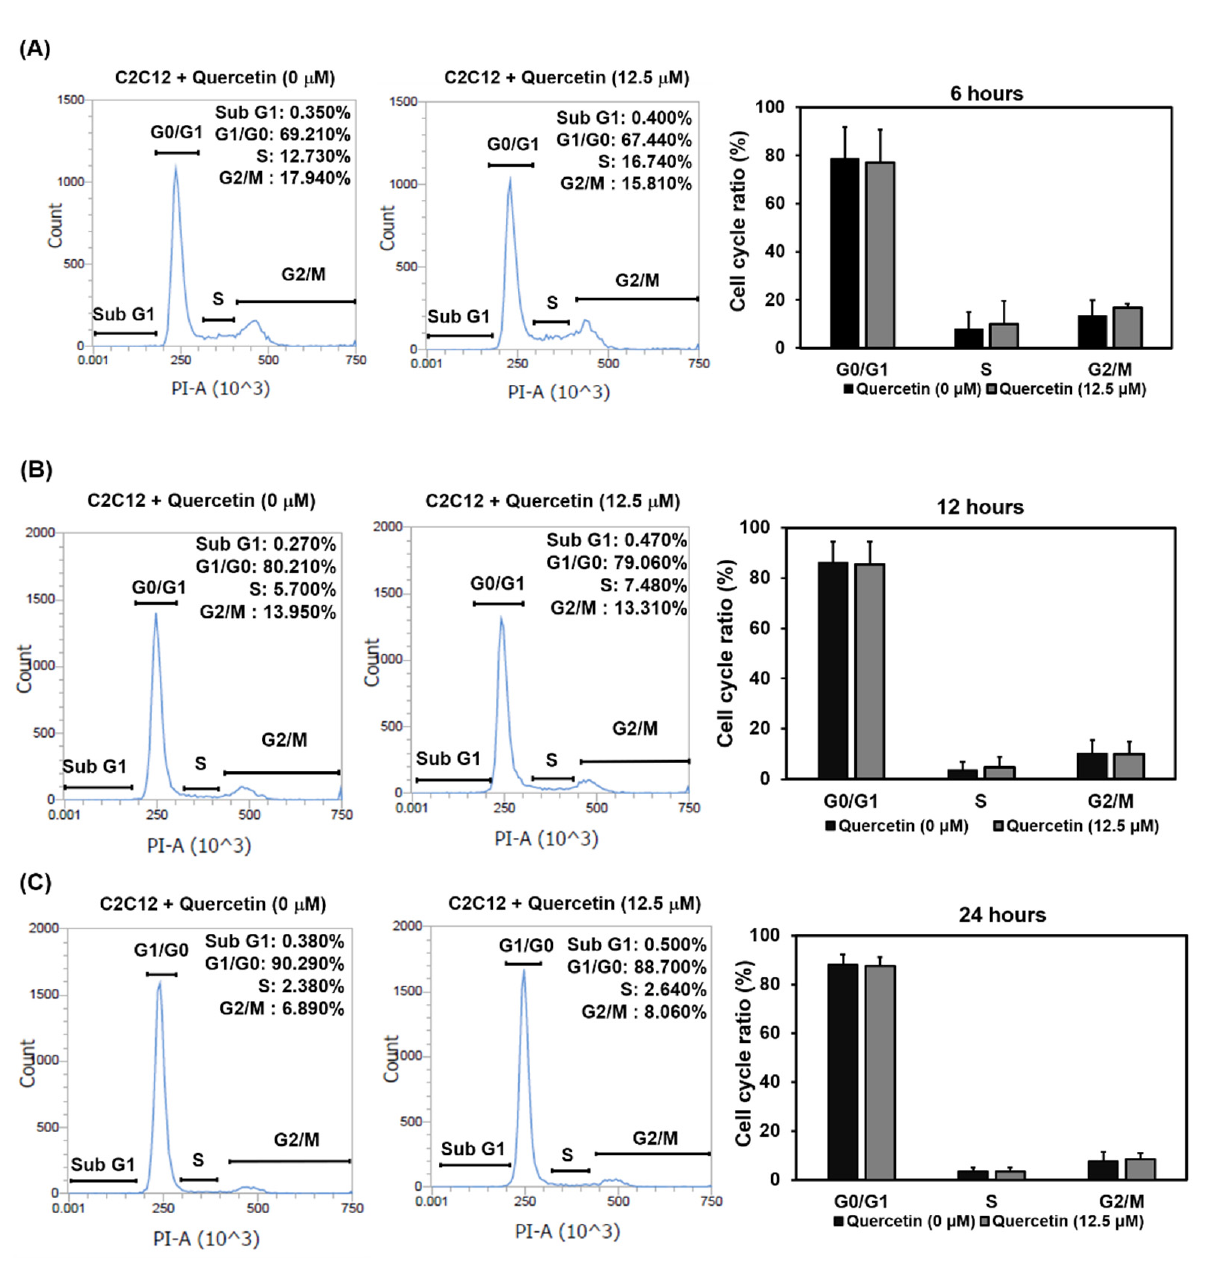
Figure 3. Quercetin did not affect the exit of myoblasts’ cell cycle at the early stage of differentiation. C2C12 cells were grown in a small plate to 80% confluency density, at which time the medium was replaced with a low-serum medium containing 2% FBS and 1% p/s to synchronize the cell cycle. After 24 h, C2C12 cells were treated with quercetin (0, 12.5 µ M) in differentiation medium (DM) for 6, 12, and 24 h. We used Attune NxT cytometer software to study C2C12 cells’ DNA stained with PI to analyze the cell cycle. The schematic diagrams depicting our flow cytometry results show changes in the cell cycle at 6 h ( A ), 12 h ( B ), and 24 h ( C ). Data are expressed as mean ± SD based on three independent biological repeats ( n = 3) for the 24 h treatment group and two independent biological repeats ( n = 2) for the 6 and 12 h treatment groups.